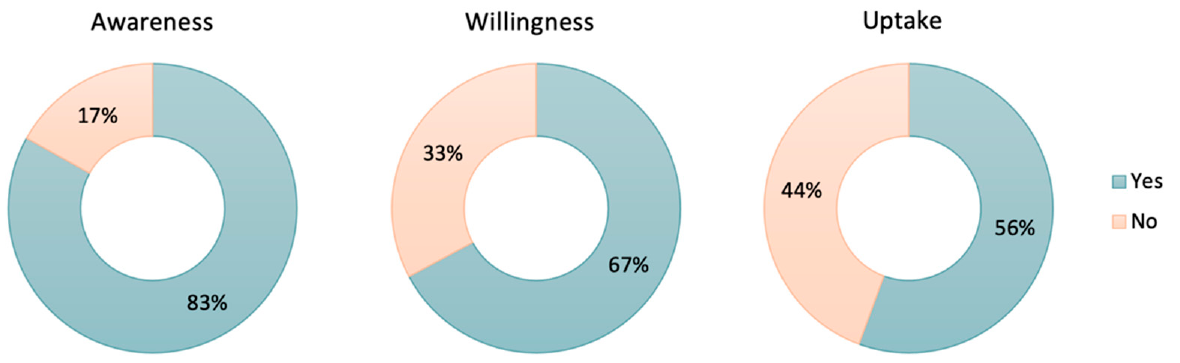
Figure 1. Awareness, willingness, and uptake of COVID-19 maternal vaccination among pregnant women eligible for vaccination during current pregnancy. Includes data only for the study period following the effective implementation of the maternal COVID-19 national recommendation, from 1 August 2021.